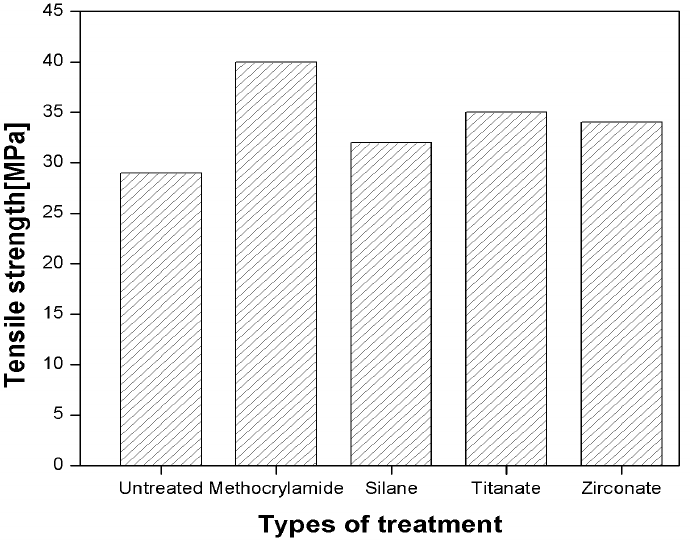
Figure 10. Influence of different chemical treatment on tensile strength of sisal/polyester composite (50 vol. % of sisal fiber). Reprinted with permission from Reference [79]. Copyright 2004, with permission from John Wiley and Sons.